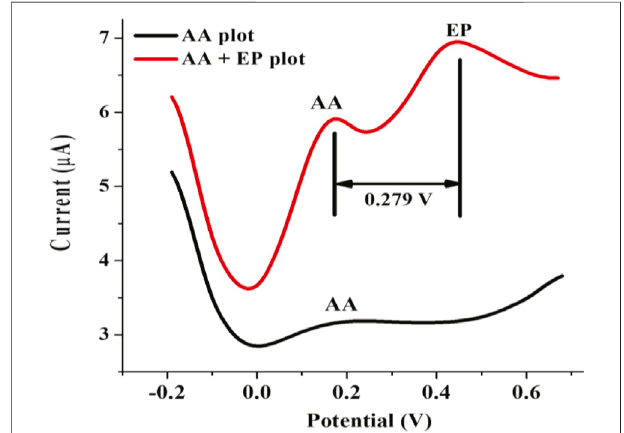
FIGURE9| Squarewavevoltammogram of0.1 mM AAandamixtureof 0.1 mM AA and 0.4 mM EP at SPSE/Fe 3 O 4 (10 mV potential step, 10 mV amplitude, 10 Hz frequency and pH